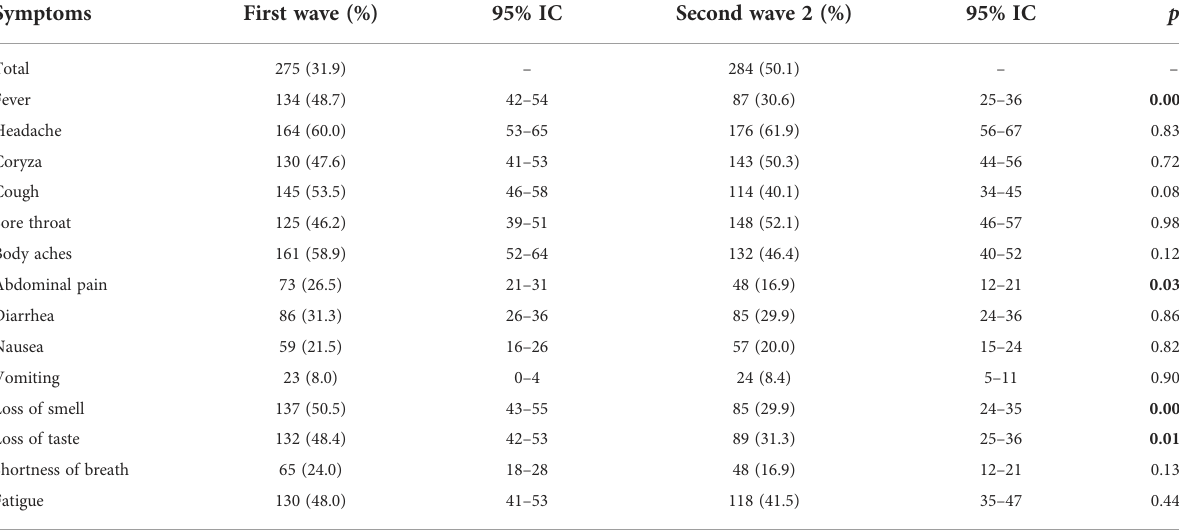
TABLE 3 Prevalence of symptom characteristics of COVID-19 in IgG+